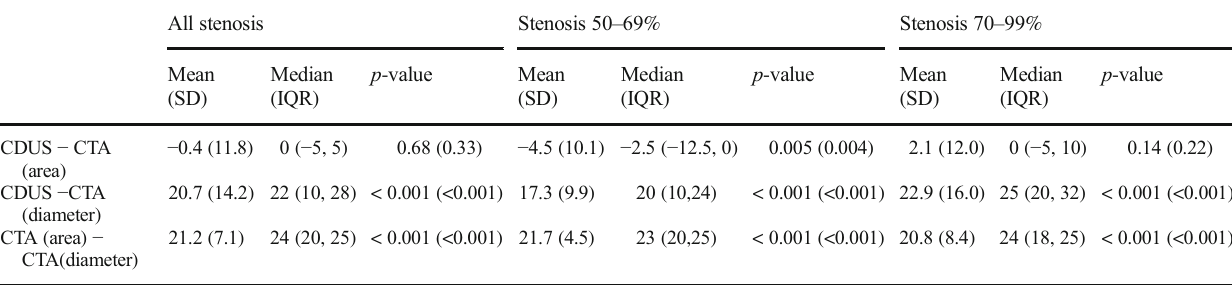
Location and spread parametersof distribution of differences in stenosis measurements[ p -values from Student ’ s t -test and Wilcoxon rank